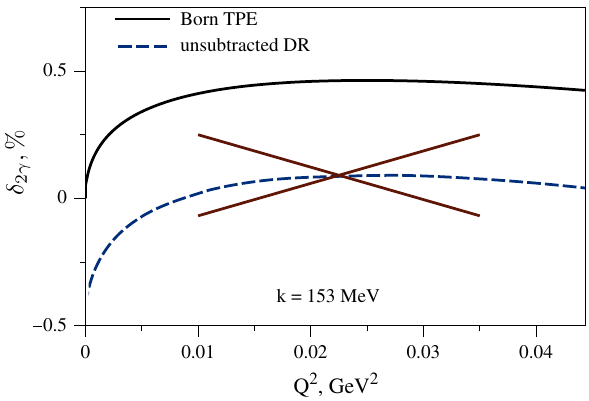
Fig. 5 TPE correction to the unpolarized elastic μ − p cross section evaluated within the unsubtracted DR framework (blue dashed curve). It is compared to the evaluation in the box diagram model (Born TPE) shown by the black solid